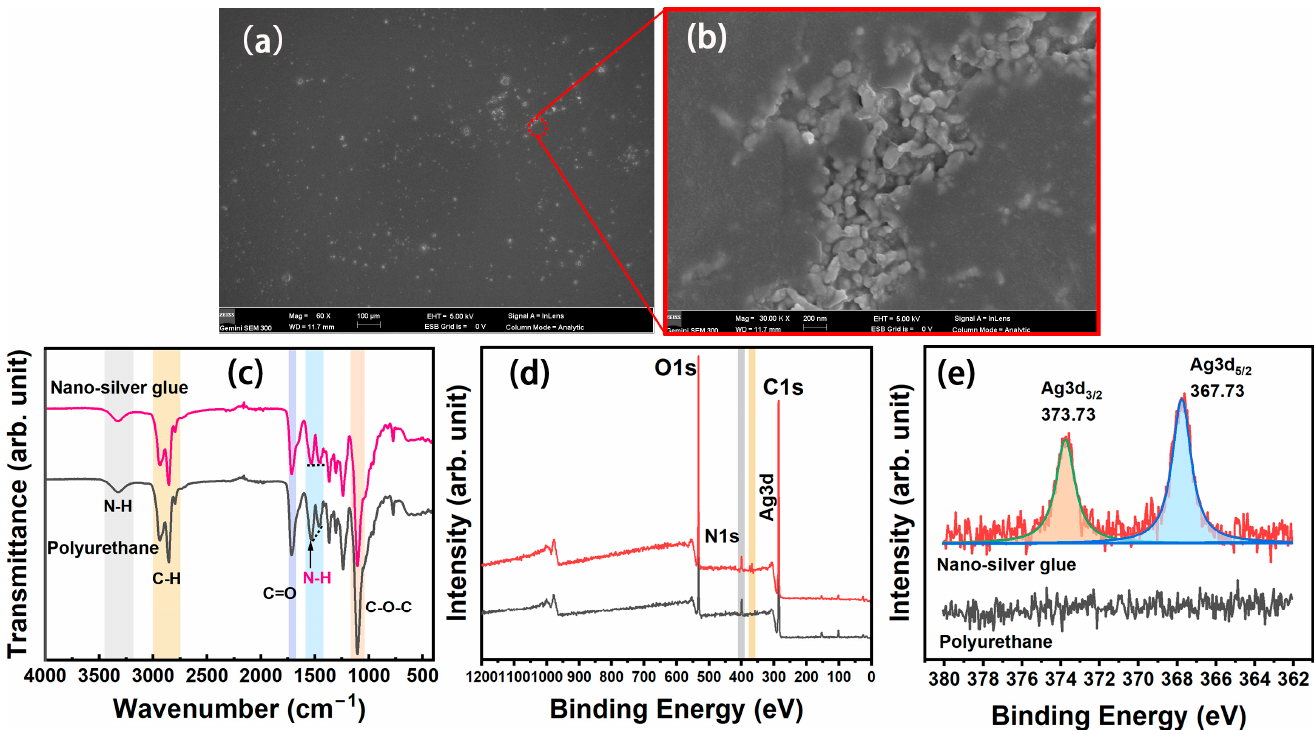
Figure 3. ( a , b ) SEM images of nanosilver film, ( c ) FTIR spectra, ( d ) wide scan, and ( e ) Ag3d XPS spectra of polyurethane and nanosilver glue films.